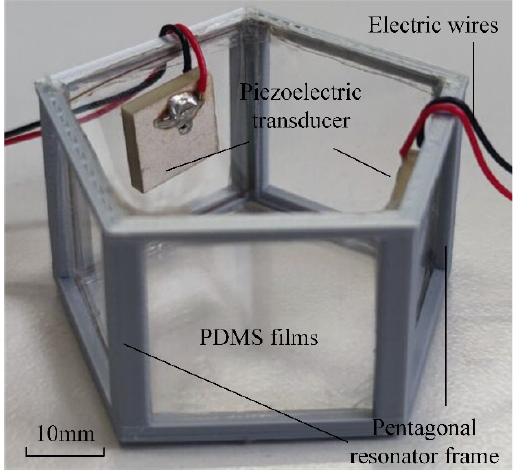
Figure 2. Structure of the pentagonal resonator.